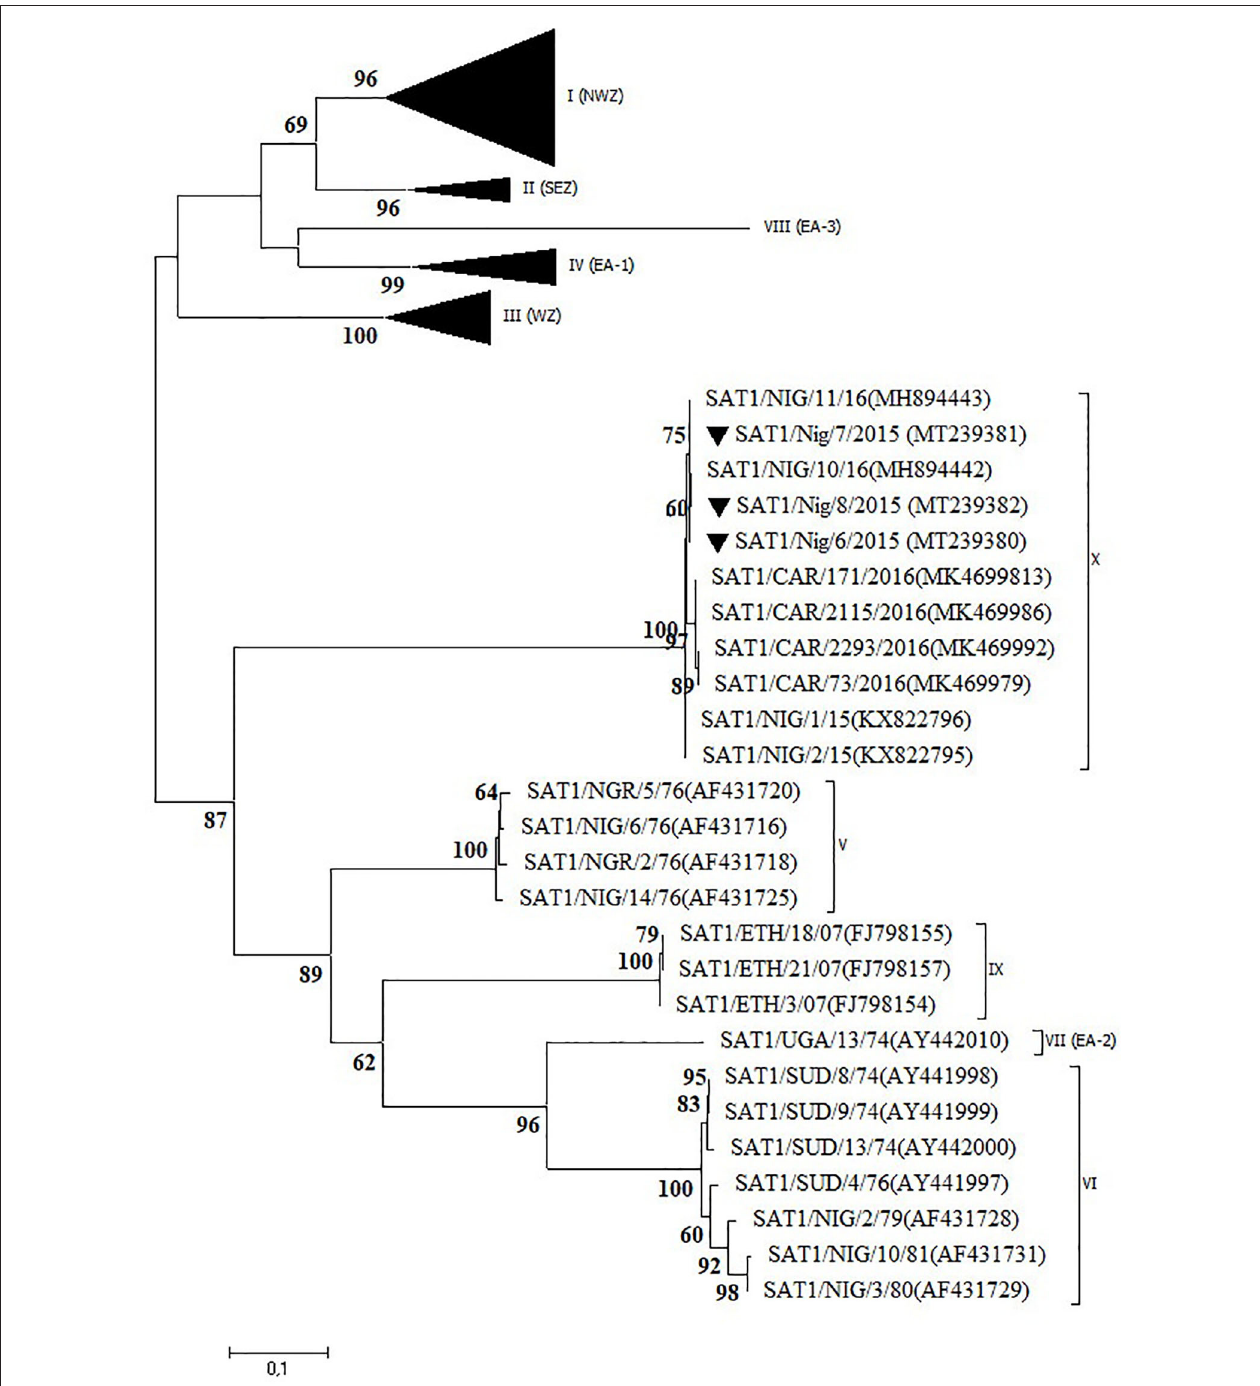
FIGURE 4 | VP1 phylogenetic tree for foot-and-mouth disease virus (FMDV) serotype Southern African Territories (SAT)1 inferred using the maximum likelihood method based on the Tamura-Nei model. Branch lengths indicate the number of substitutions per site. Bootstrap values ≥ 60% are indicated at the nodes. Novel Nigerian FMDV from this study from Plateau is indicated with